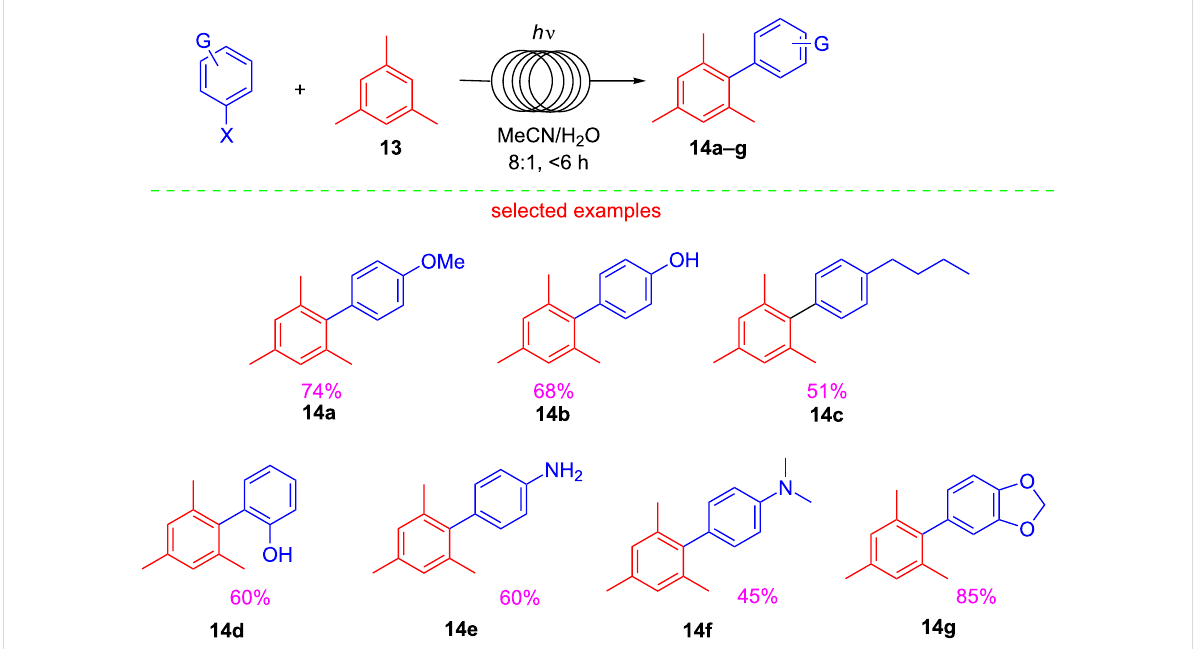
Scheme 15: Synthesis of biaryls 14a–g under photochemical flow conditions.